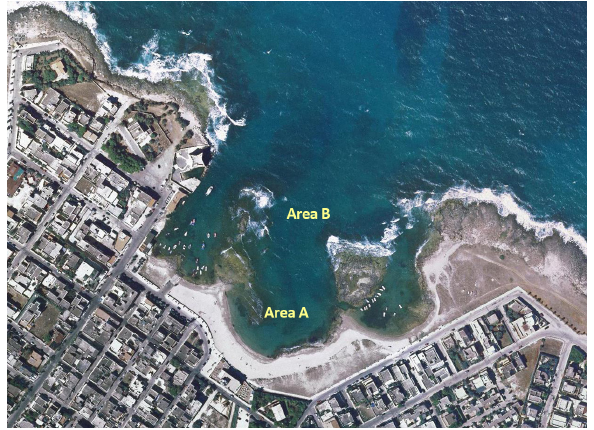
Figure 1. Torre. S. Sabina bay (BR), along the Adriatic coast of Salento,